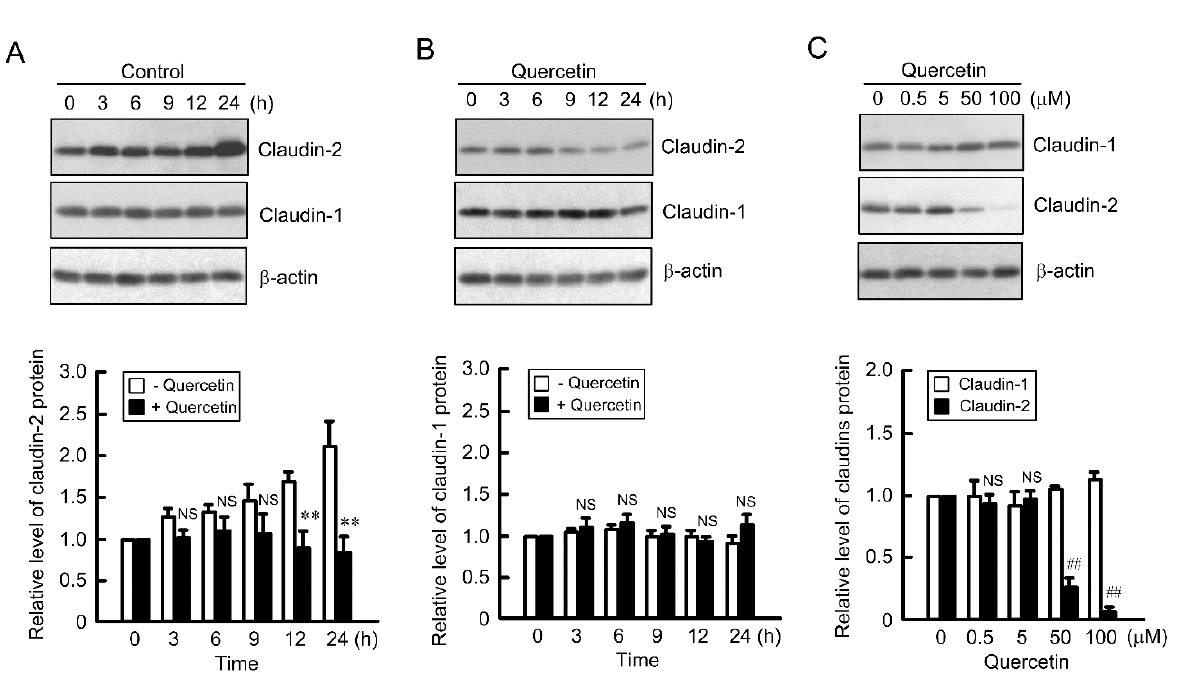
Figure 1. Decrease in claudin-2 expression by quercetin. ( A and B ) A549 cells were incubated in the absence (−) and presence (+) of 50 μM quercetin for the periods indicated. Cytoplasmic fractions were immunoblotted with anti-claudin-2, claudin-1, or β-actin antibody. The expression of claudin-1 and claudin-2 was represented relative to the values in 0 h; ( C ) Cells were incubated with quercetin at the indicated concentrations for 24 h. Cytoplasmic fractions were immunoblotted with anti-claudin-1, claudin-2, or β-actin antibody. The expression of claudin-1 and claudin-2 was represented relative to the values in 0 μM. n = 3–4. ** p < 0.01 significantly different from −quercetin. ## p < 0.01 significantly different from 0 μM. NS, not significantly